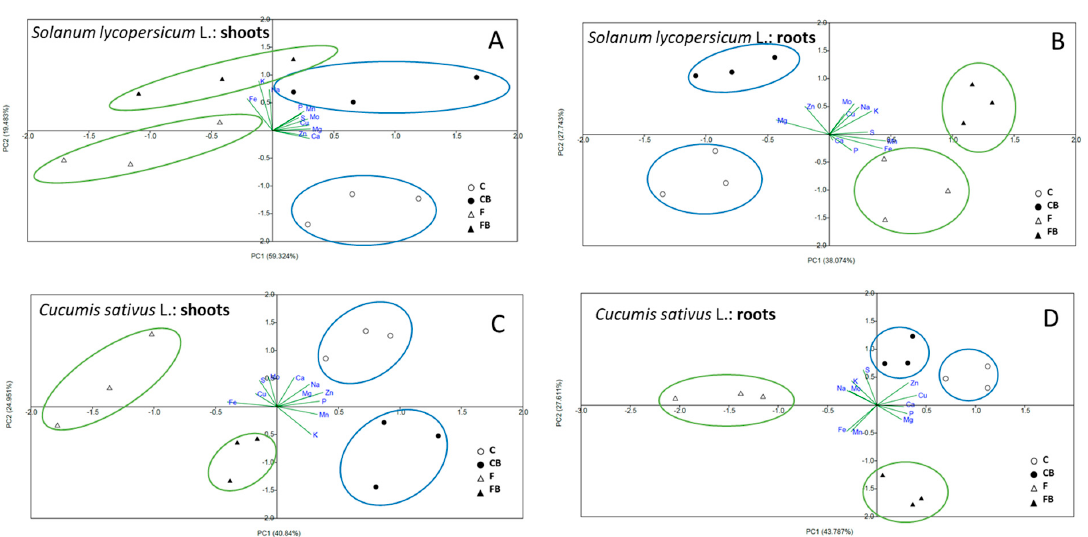
Figure 3. Principal component analysis of shoot and root ionome of tomato ( A , B ) and cucumber ( C , D ) plants. Empty symbols represent plants not supplemented with a plant protein-based hydrolysate biostimulant, while full symbols represent plants supplemented with a protein-based hydrolysate biostimulant. Plants were grown in either a full nutrient solution supplied without or with the plant-derived protein hydrolysate (C and CB, respectively, both represented by the circles) or a Fe-deficient nutrient solution without or with the plant-derived protein hydrolysate (F and FB, respectively, both represented by the triangles).